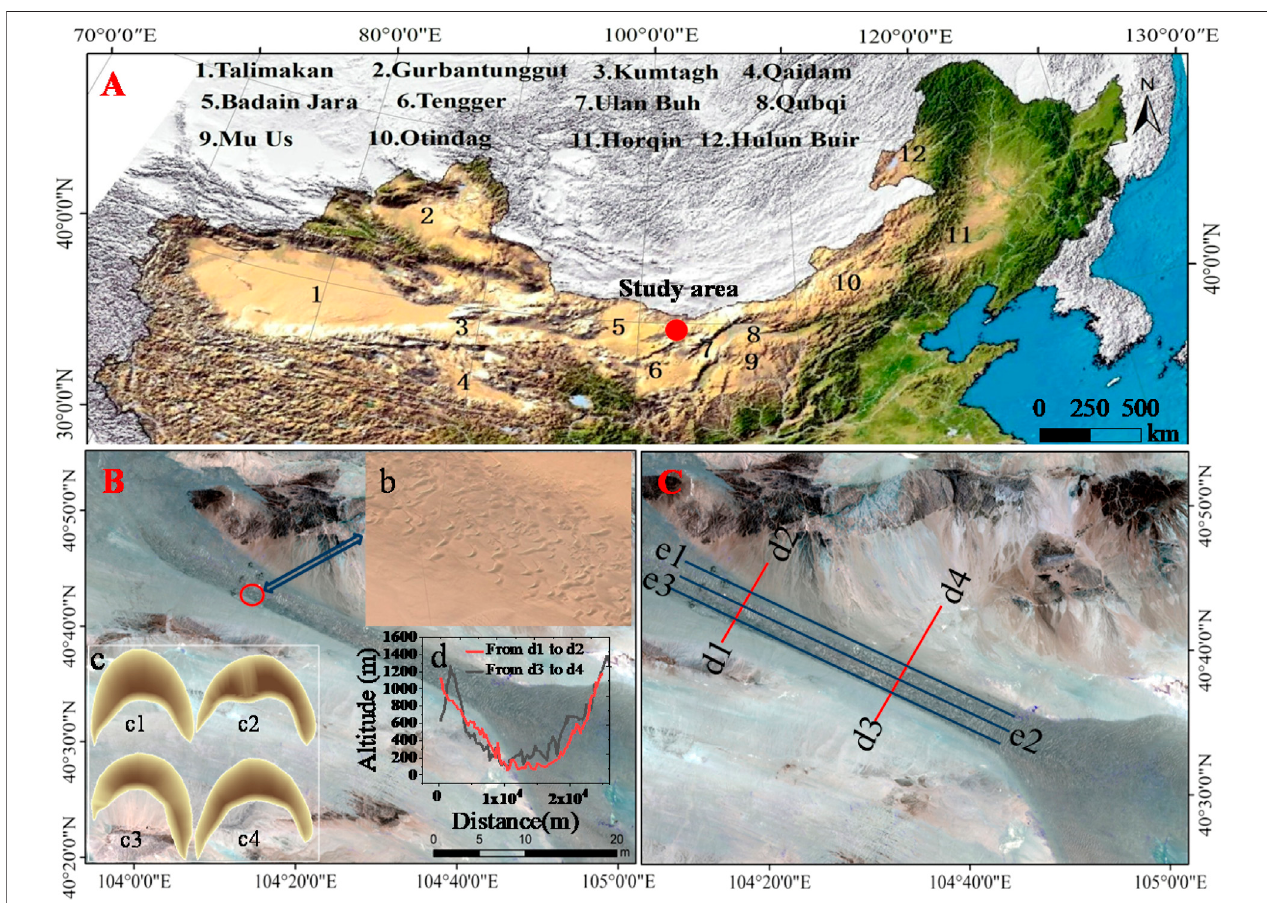
FIGURE 1 | The location of the study area and the types of dunes. Note: panel (A) shows the speci fi c location ofthe study area, panel (B) shows the main types of sand dunesinthestudy area,and panel (C) showsthatthetopographyofthesub-marekdesertishigh onboth sidesand lowinthemiddle, forming a “ narrowpipe ” -like